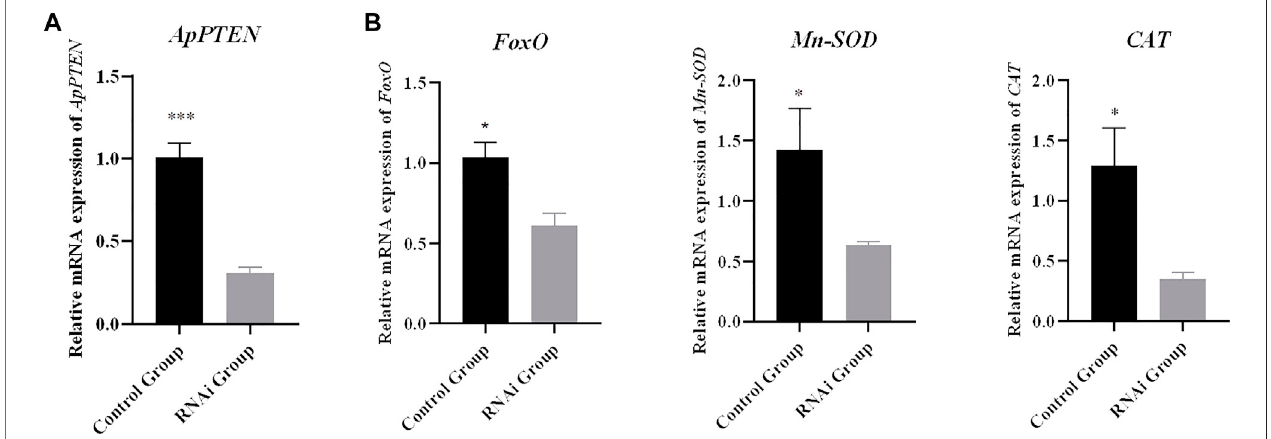
FIGURE 10 | Relative mRNA expressions of target genes (B) after inhibition of ApPTEN (A) expression (* p < 0.05 and *** p < 0.001).